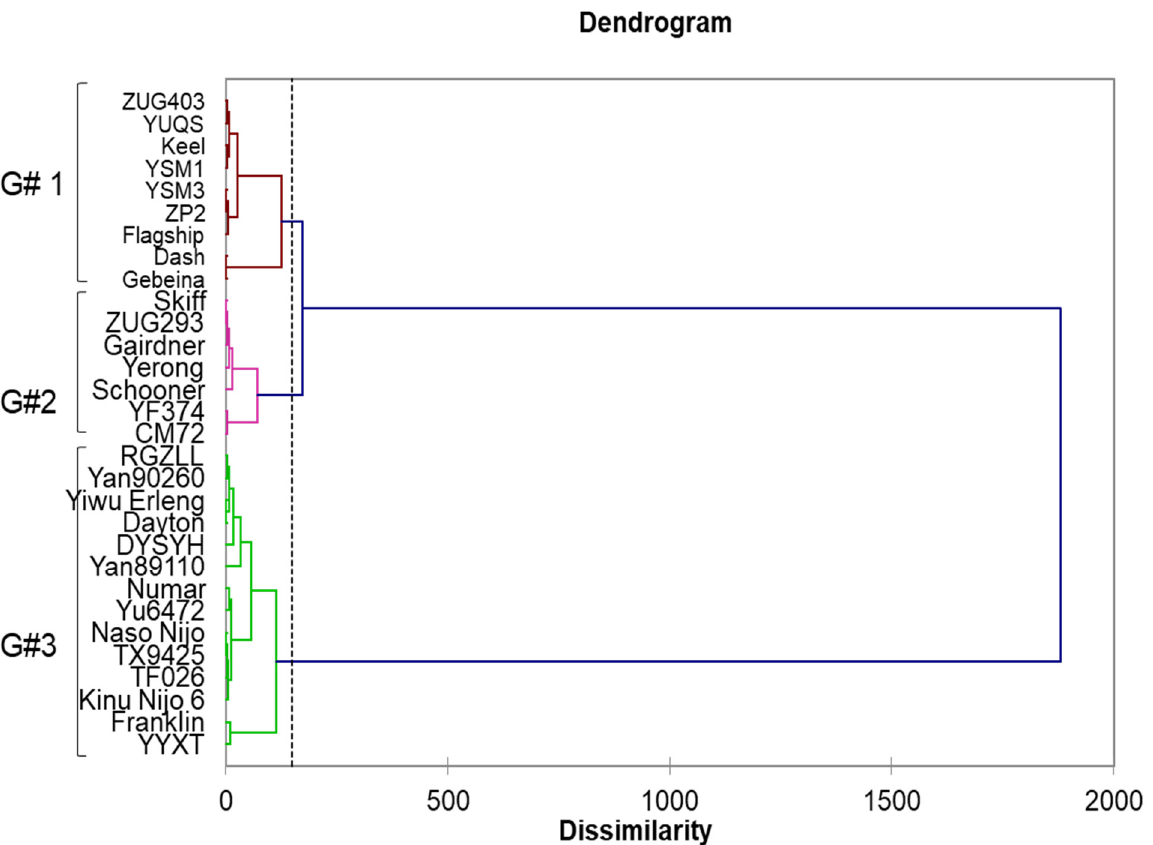
Figure 1. Dendogram based on all K treatments . The dendrogram shows fusion levels at which the groups join. The vertical dashed line represents the truncation into three genotype groups using Ward’s agglomerative clustering algorithm. Group one contains nine genotypes (ZUG403, YUQS, Keel, YSMI, YSM3, ZP2, Flagship, Dash and Gebeina), group two contains seven genotypes (Skiff, ZUG293, Gairdner, Yerong, Schooner, YF374 and CM72), group three contains fourteen genotypes (YYXT, Dayton, DYSYH, Franklin, Yiwu Erleng, Yu6472, TF026, TX9425, Yan89110, Yan90260, Kinu Nijo 6, Naso Nijo, Numar and RGZLL).